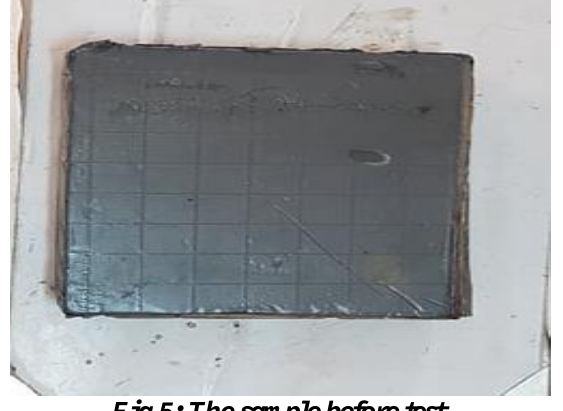
Fig.5: The sample before test.